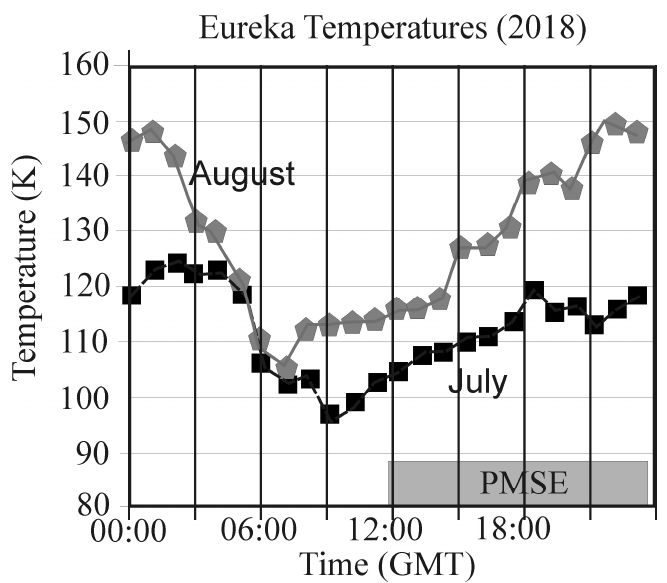
Figure 6. Temperature time-series for “composite days” for July and August, 2018 from Eureka. The July case corresponds to an approximate average of the 85–95 km altitude region, while the August estimates are for smaller height coverage of 85–91 km. The shaded region shows the time of occurrence of the majority of PMSE. As the longitude is 86 o W, local solar time is about 6 h behind GMT.